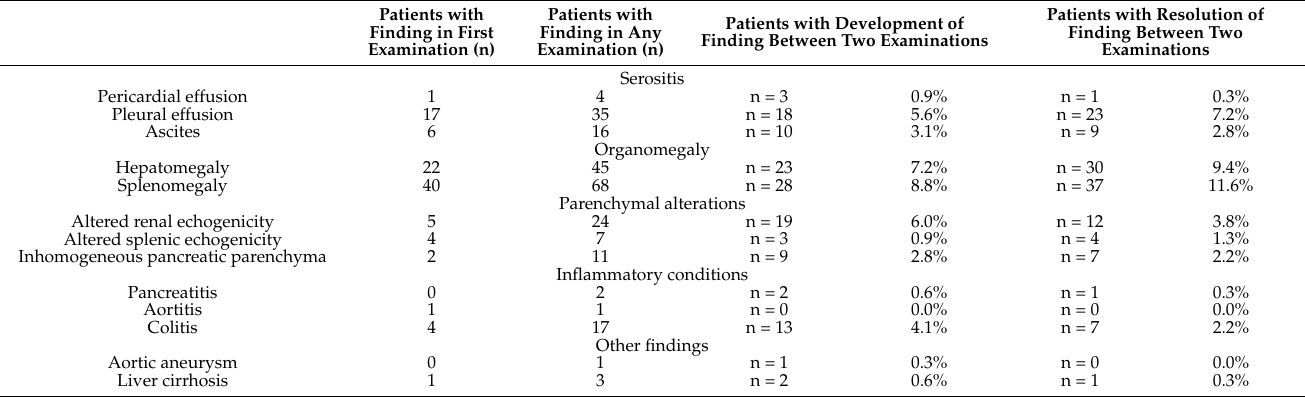
Table 3. Changes over time in 318 patients with repetitive abdominal ultrasound